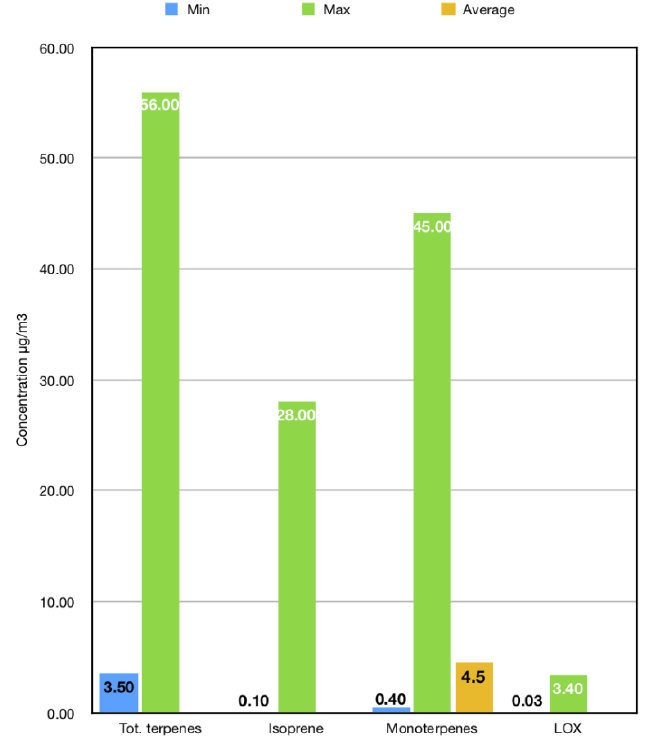
Figure 3. Atmospheric concentration of BVOCs under forest canopy [16,31,32,34,38–44]. Abbreviations: Tot. terpenes = total concentration of terpenes; LOX = products of the lipoxygenase (LOX) pathway.